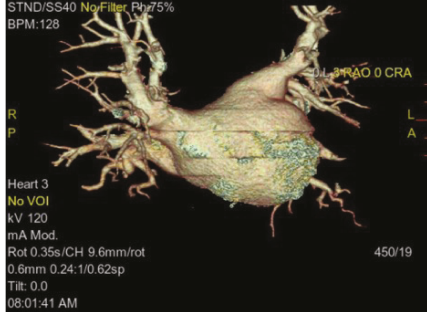
Figure 2: CTA of the pulmonary veins at anteroposterior (AP) view showing there is no left atrial appendage.